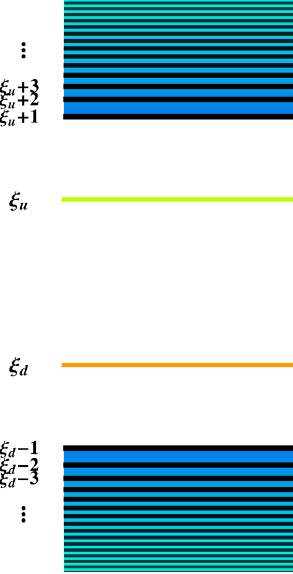
Figure 3. Energy levels of different orbitals when an exciton first forms in a conjugated polymer.